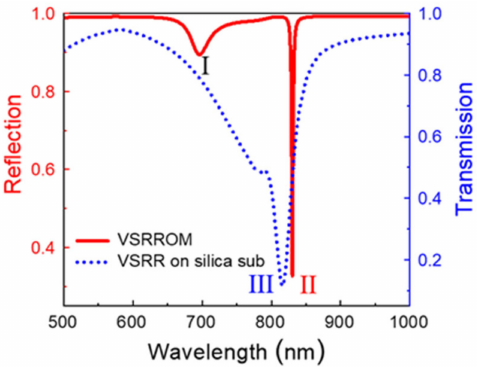
Figure 2. The calculated reflection of Au VSRRs on Au substrate and transmission of Au VSRRs on silica substrate. (I) denotes the MP resonance and (II) denotes the narrowband mixed mode of the Au VSRRs on Au substrate. (III) denotes the transmission dip of the SRR on a silica substrate. Figure 3 shows the normalized electromagnetic field ( H / H in and E / E in ) distributions on the xoz plane for the dip (I) and dip (II) of the Au VSRRs on Au substrate and for the dip (III) of the Au VSRRs on silica substrate, respectively. Obviously, both the magnetic field and electric field distributions of dip (II) are very similar to those of the dip (I) resonance, but the maximum magnetic field and the maximum electric field at the resonance of dip (II) are enhanced to be about 50 and 70 times of incident magnetic and electric fields, which are 2 and 2.33 times as strong as the corresponding values at the dip (III) resonance of the Au VSRRs on silica